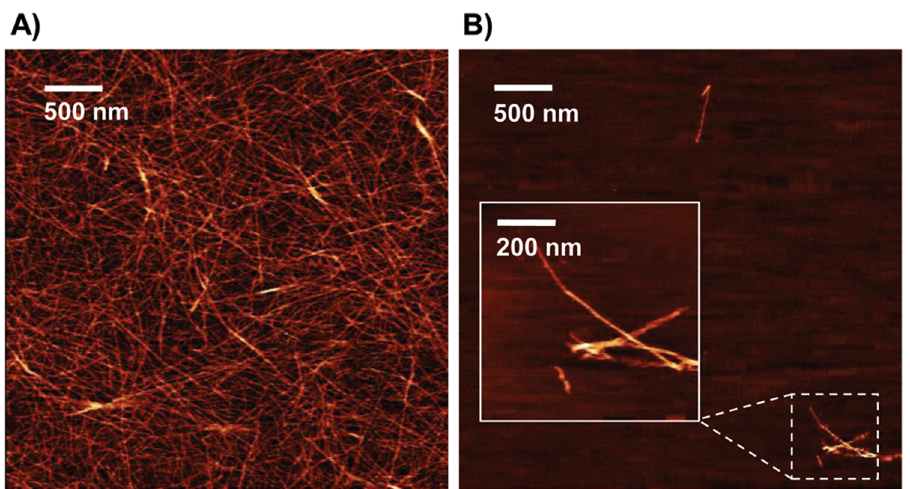
Fig. 4 AFM images of synthetic PSM α 1 amyloid fi brils. a PSM α 1 peptide samples solubilized with DMSO were allowed to aggregate at high concentrations (437 μ M), and the resulting fi brils exhibited extensive surface coverage, with each fi bril measuring ~10 nm in diameter and 0.1 – 4 μ M in length. b PSM α 1 was also allowed to aggregate at 44 μ M, yielding comparable but less dense fi